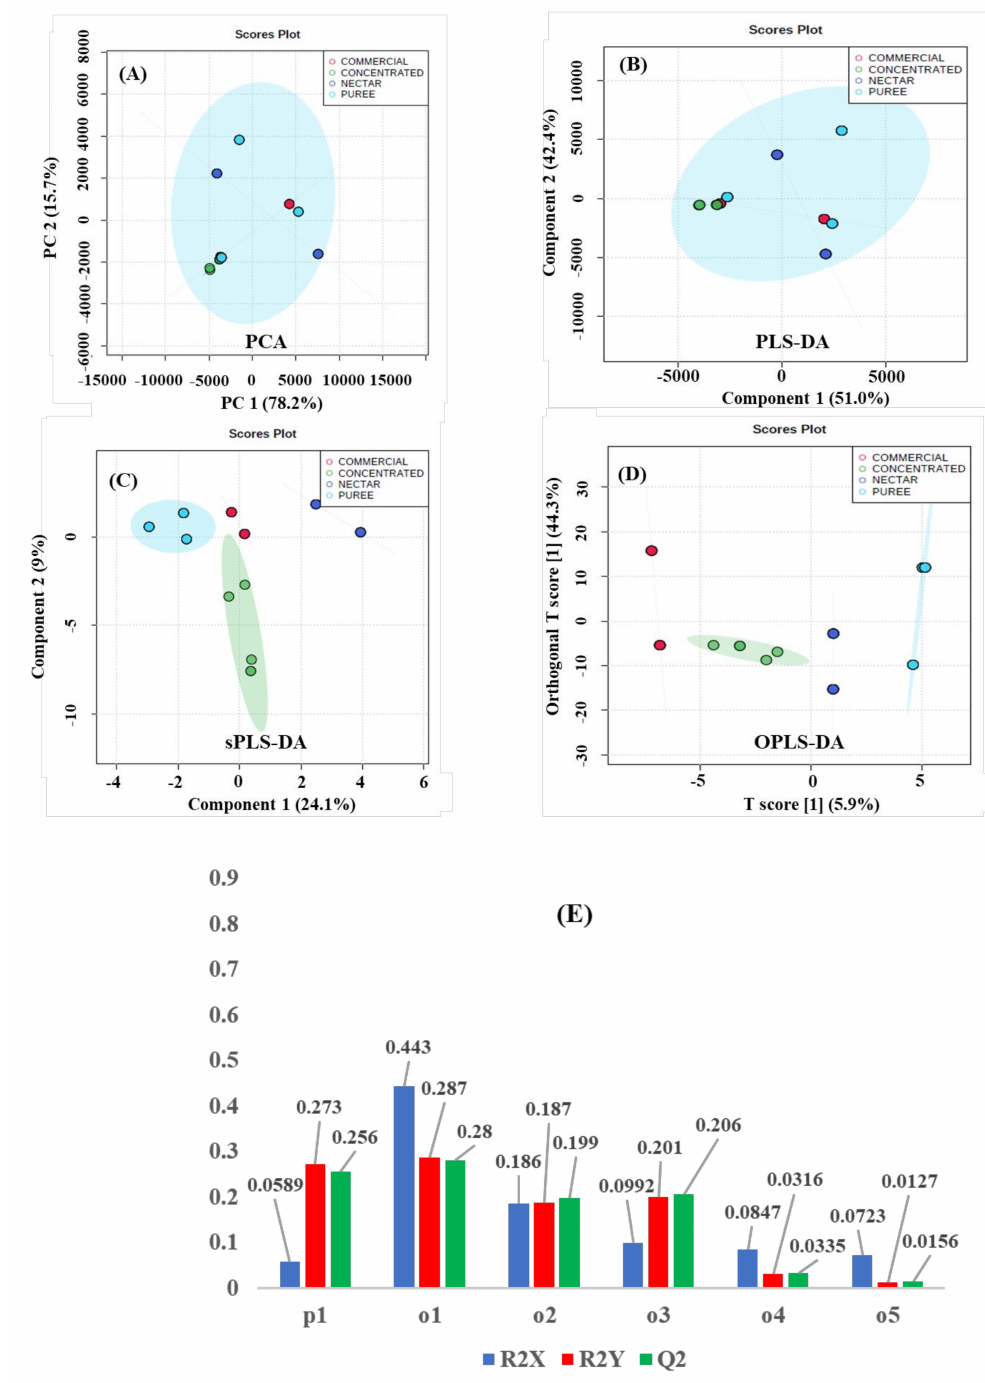
Figure 5. Score plots of the unsupervised principal component ( A ) and supervised standard partial (PLS-DA) ( B ), sparse (sPLS-DA) ( C ) least square, and orthogonal projections to latent structures discriminant analysis (OPLS-DA) ( D ). It shows commercial nonconcentrated juice (red); concentrated juice (green); nectar (blue); and puree (cyan) fruit drinks (apple, apricot, and orange), modeled from the automatized { 1 H water_presat NMR} data matrix (Figure S2) as the “type of juice” holistic fingerprint. T2 Hotelling’s ellipses have a 95% confidence level in all cases. For PCA, PLS-, and sPLS-DA holistic fingerprints, the explained variances are highlighted in parentheses along the axis. ( E ) For OPLS-DA, a permutation analysis between one predictive (p1) and five orthogonal (o1, o2, o3, o4, and o5) components produced the observed and cross-validated R2X, R2Y, and Q2